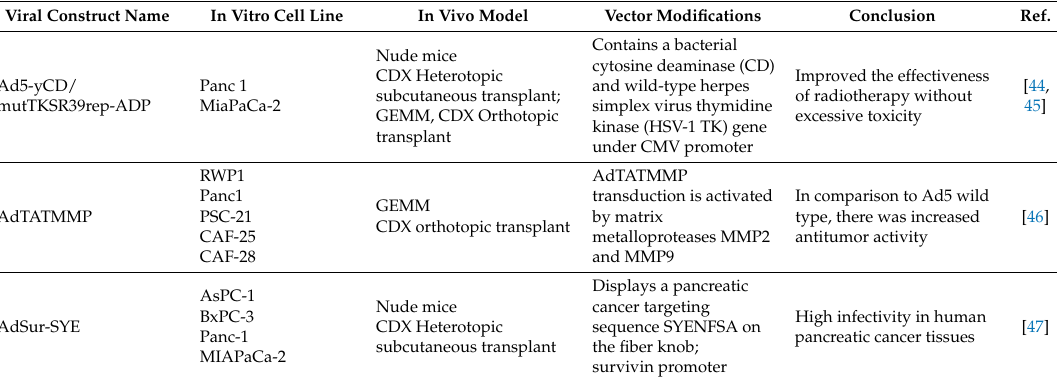
Table 6. Preclinical research in pancreatic